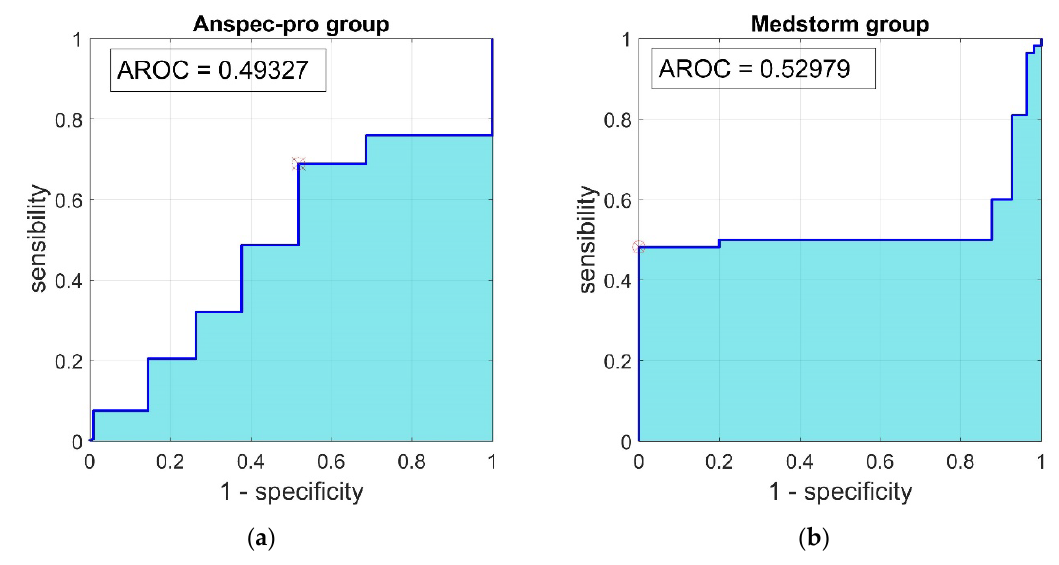
Figure 5. Receiver-operating characteristic (ROC) curve for the relationship between sensitivity and 1–specificity, determining the performance of ( a ) Anspec-pro index, ( b ) Medstorm index, to predict